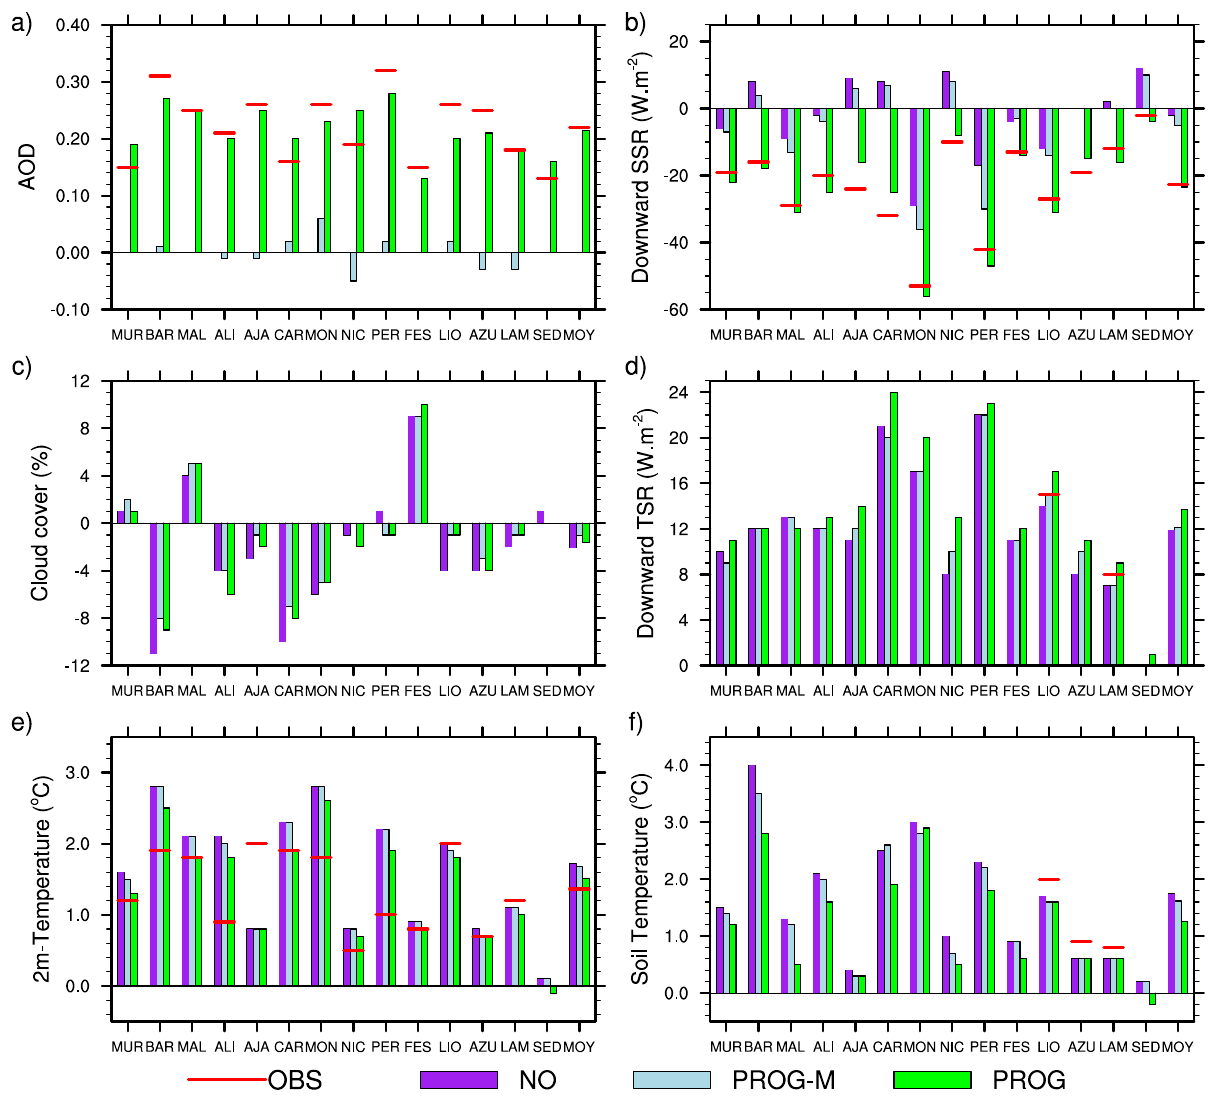
Fig. 11. Average wind (km/h, colored barbs) and geopotential (mgp, black lines) at 850 hPa for the set of all the days (left) and the dusty days (right) defined in Murcia (purple cross).